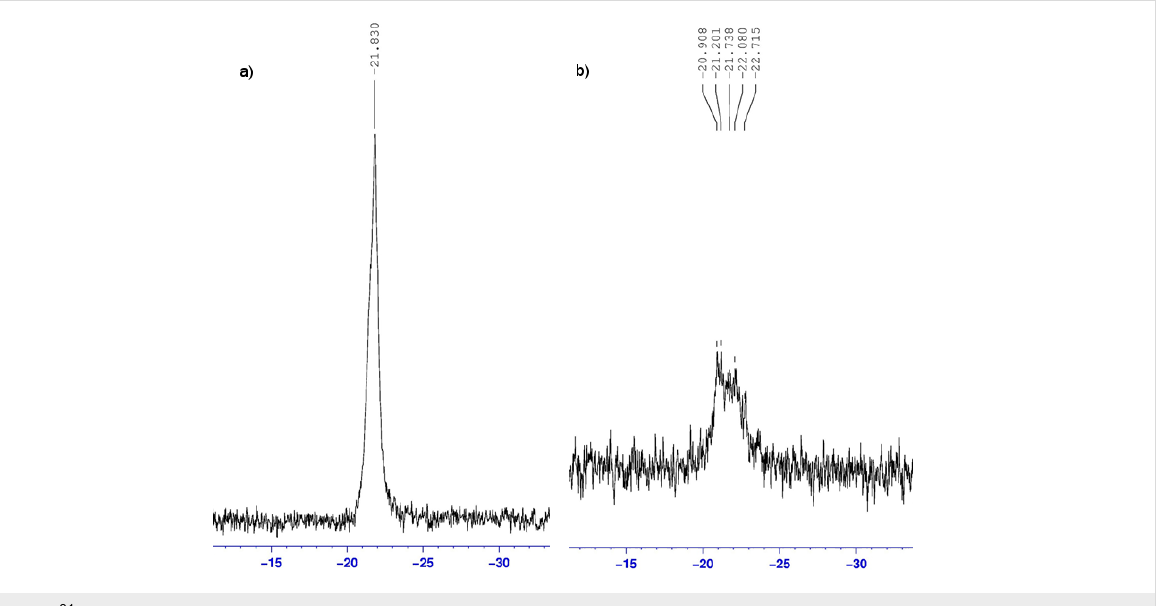
Figure 2: 31 P NMR spectrum of 3b in a) DMF- d 7 at 25 °C and b) D 2 O at 25 °C.